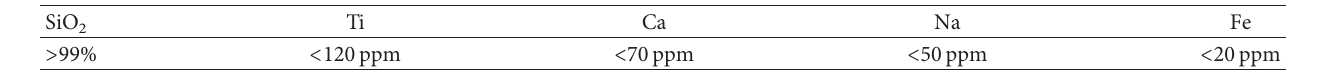
Table 3: Specifications of consumed nanosilica.